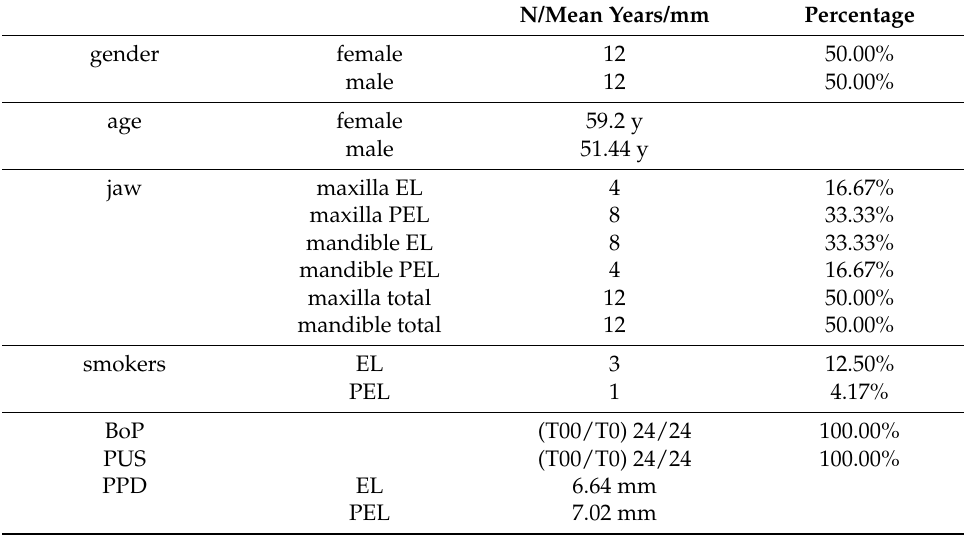
Table 1. Overall patient data at T0.